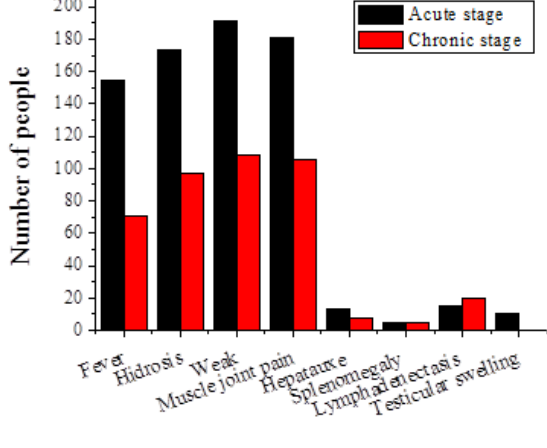
Figure 5. Utilization of protective tools by the key